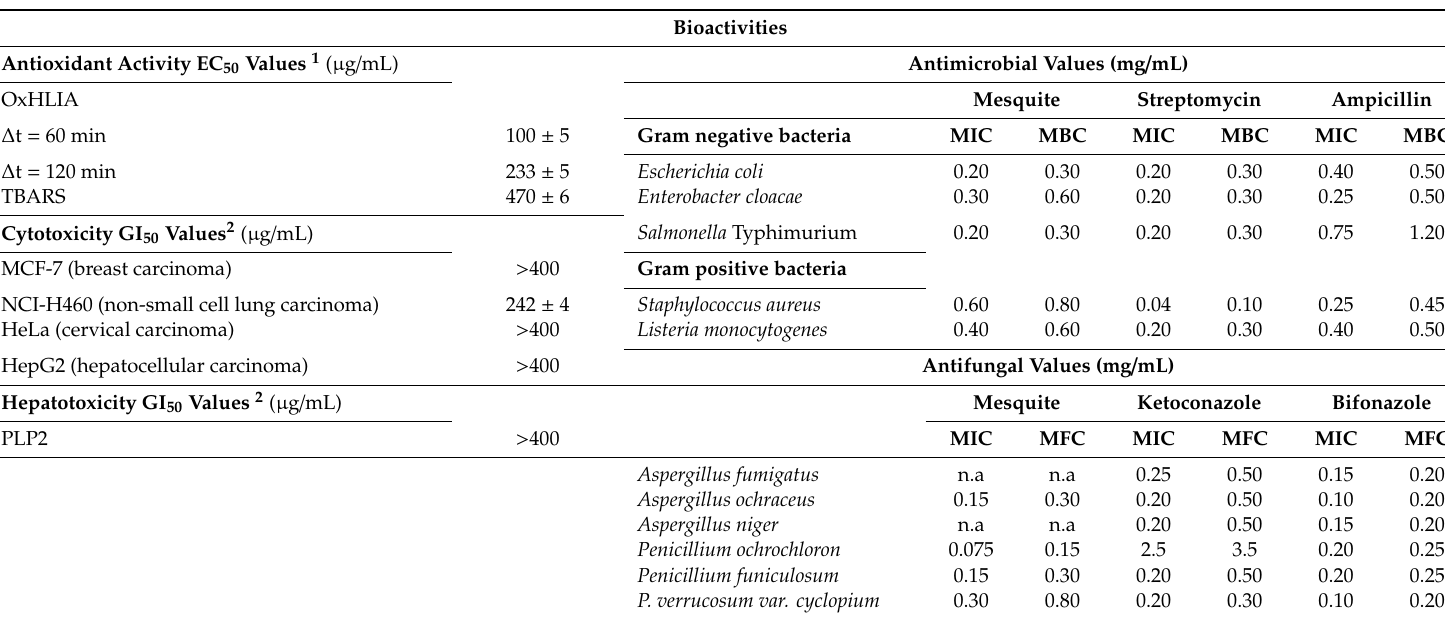
Table 3. Antioxidant, cytotoxicity, hepatotoxicity, and antimicrobial activities of Prosopis pallida flour derived from pod mesocarp (mean ±